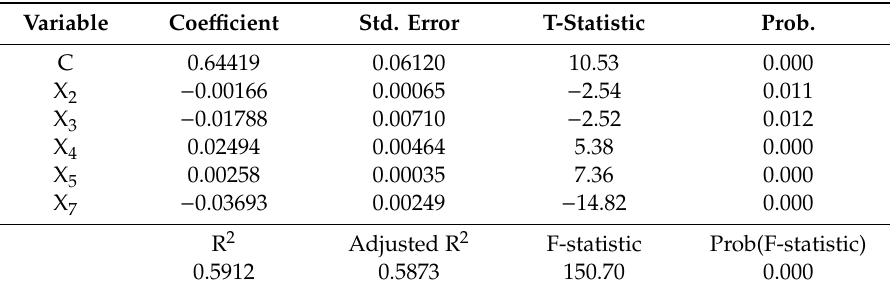
Table 5. The results of the stepwise